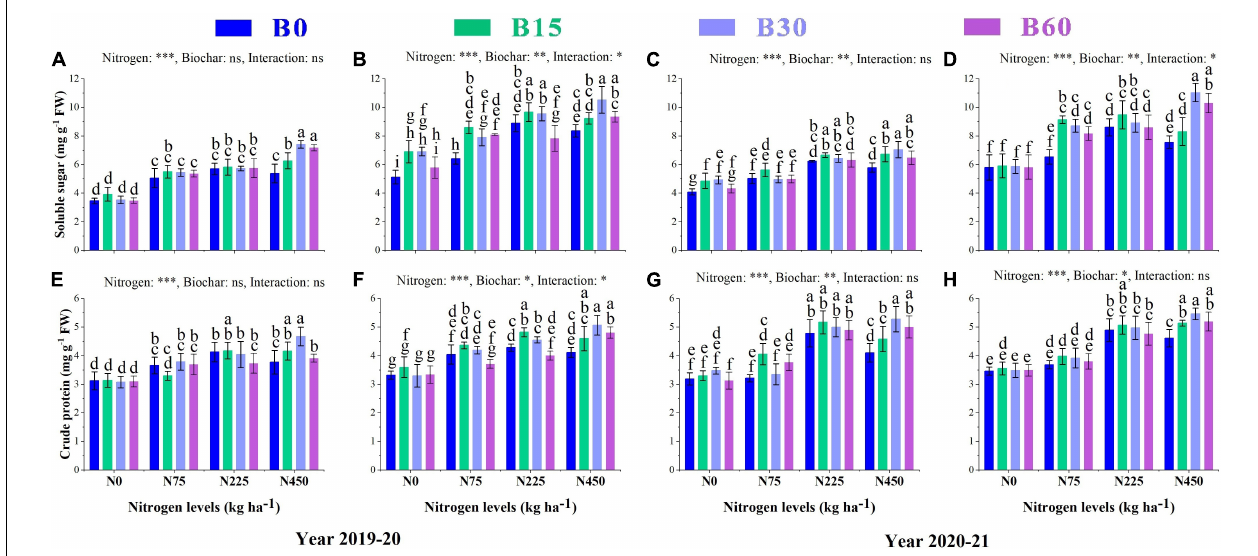
FIGURE 5 | Integral effects of biochar and nitrogen on soluble sugar (A) SS and (B) FS in 2019–2020 and (C) SS and (D) FS in 2020–2021 and crude protein (E) SS and (F) FS in 2019–2020 and (G) SS and (H) FS in 2020–2021. SS: seedling stage, FS: flowering stage. B0: 0 t ha − 1 biochar; B15: 15 t ha − 1 biochar; B30: 30 t ha − 1 biochar; B60: 60 t ha − 1 biochar; N0: 0 kg ha − 1 nitrogen; N75: 75 kg ha − 1 nitrogen; N225: 225 kg ha − 1 nitrogen, and N450: 450 kg ha − 1 nitrogen, error bars represent standard error for each treatment in three replicates. Different letters on each bar represent significant differences according to the LSD test ( p < 0.05).